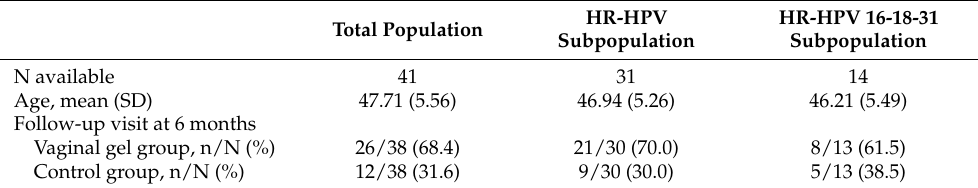
Table 1. Sociodemographic data and patients at follow-up visit at 6 months.